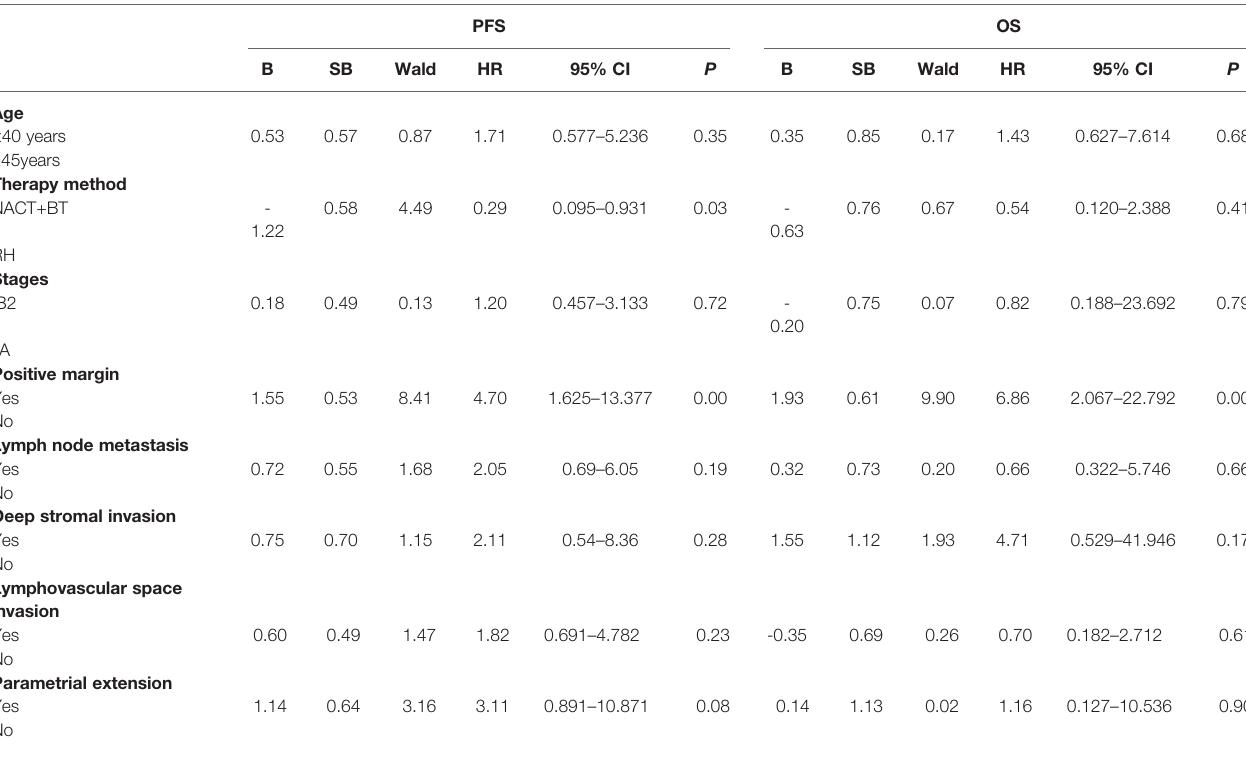
TABLE 5 | Multifactor analysis of factors affecting 5-year progression-free survival (PFS) and overall survival (OS) in local advanced cervical cancer